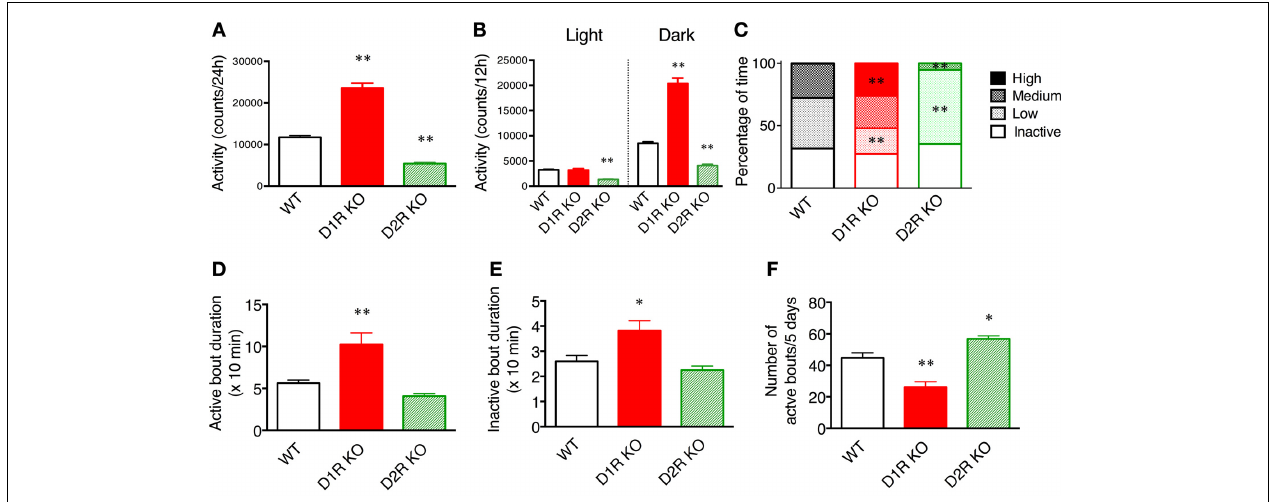
FIGURE 2 | Spontaneous motor activity of mice in home cages. The home cage motor activity of WT ( n = 8), D1R KO ( n = 4), and D2R KO ( n = 8) mice was monitored continuously for 5 days in a 12h light/dark cycle. (A) Activity over 24h. (B) Activity in 12h light/dark phase. (C) Activity states in the dark phase were classified as follows on the basis of the numbers of movements: inactive state (0–9 counts/10min), low- (10–199 counts/10min), medium- (200–499 counts/10min), high- (over 500